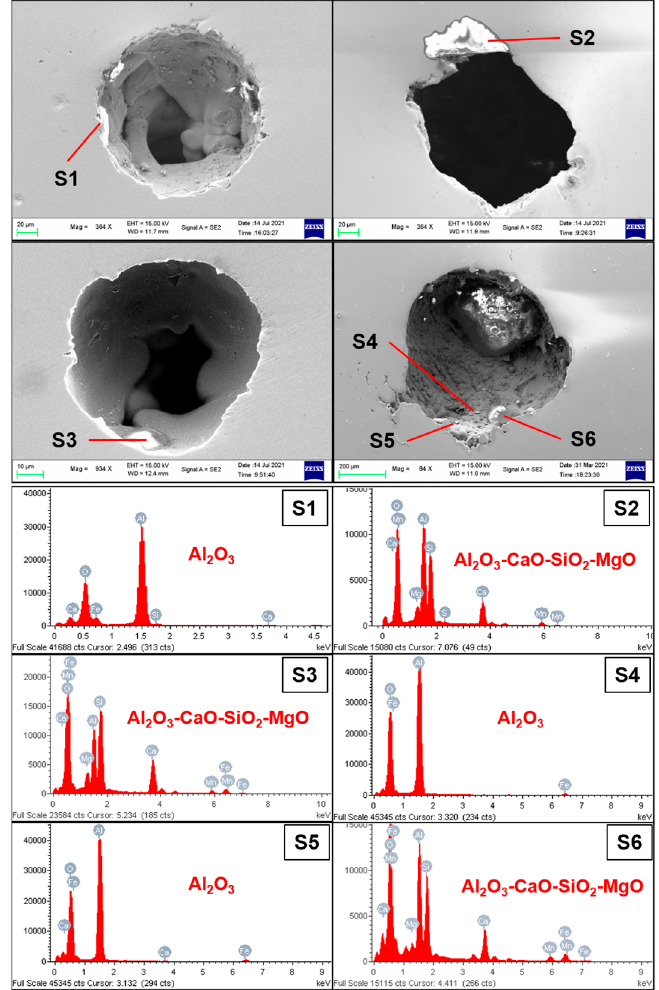
Figure 15. SEM images and EDS results of inclusions adhering to bubbles.